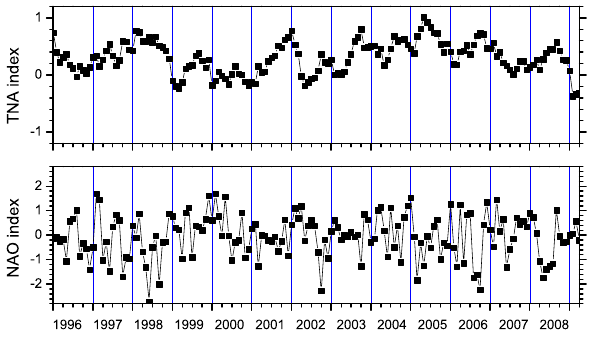
Fig. 7. Slope (α − 1 ) throughout the troposphere. Left panel for Kiruna and right panel for Iza˜na. Black, red, and green lines rep- resent the FTIR measurements, the nudged model run, and the free model run, the hatched areas represent the 1 σ significance intervals. The open squares upon the bottom x-axis represent the slope (α − 1 ) for the column integrated